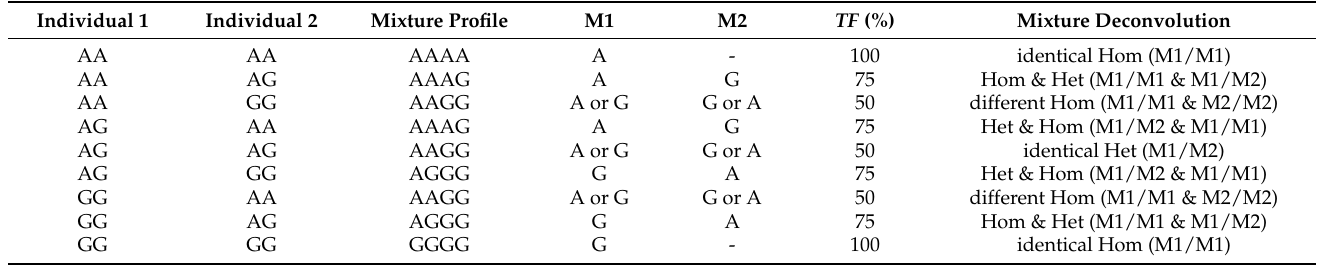
Table 1. Mixing two random individuals at the ratio of